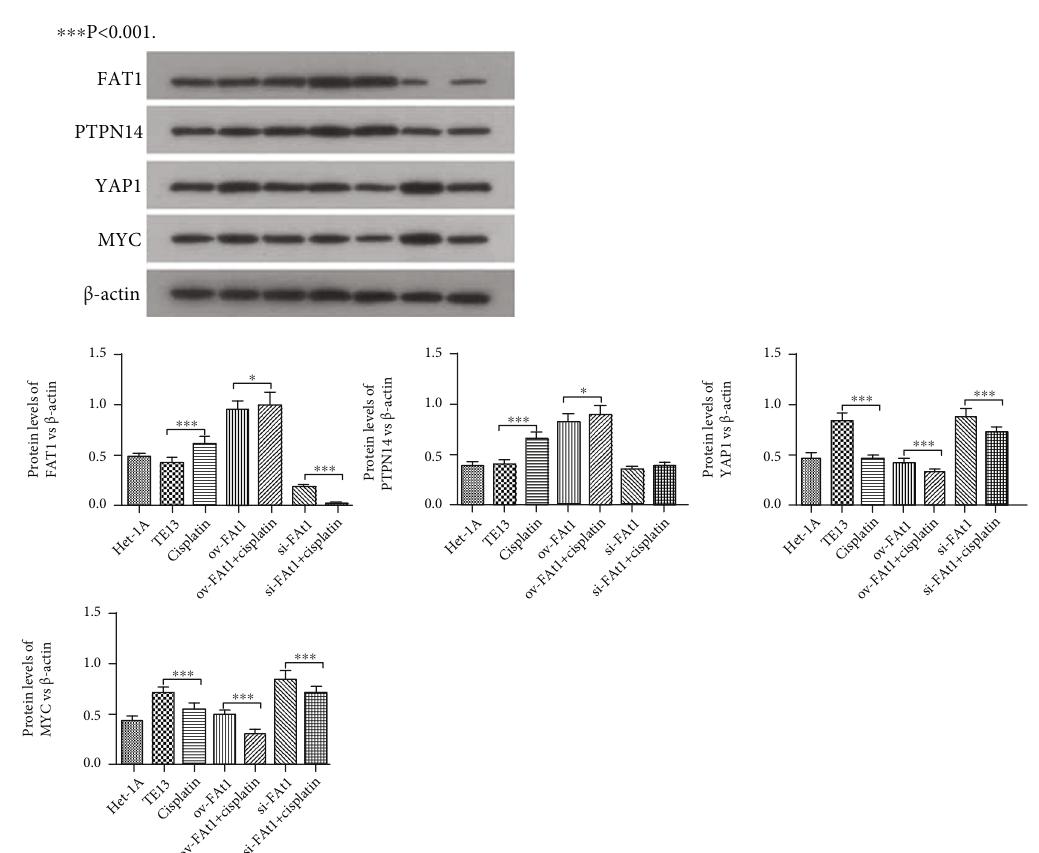
Figure 7: Western blot was performed to detect the protein levels of Yap1, PTPN14, FAT1, and Myc. WB was used to evaluate the expression of Yap1, PTPN14, FAT1, and Myc. FAT1 signi fi cantly enhanced the protein level of PTPN14 and inhibited the protein levels of Yap1 and Myc. Meanwhile, knockdown of FAT1 signi fi cantly downregulated the protein level of PTPN14 and increased the protein levels of Yap1 and Myc. ∗ P < 0 : 05 , ∗∗∗ P < 0 : 001